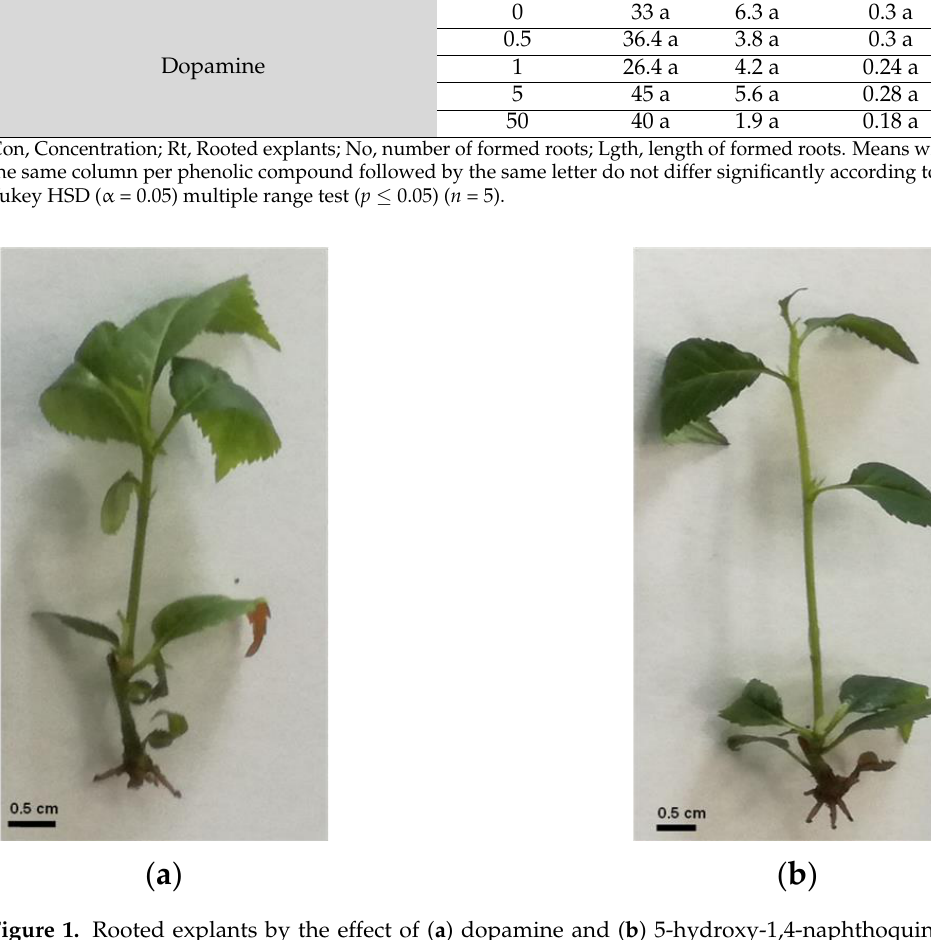
Figure 1. Rooted explants by the effect of ( a ) dopamine and ( b ) 5-hydroxy-1,4-naphthoquinone cultivated in rooting medium without IBA.